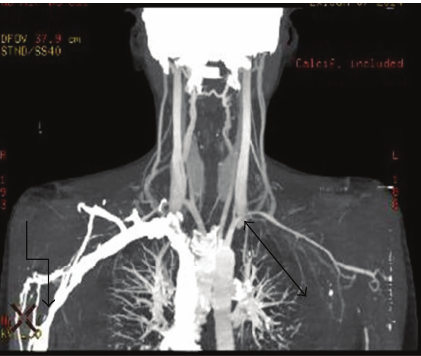
Figure 1: Discoid rash over the back.